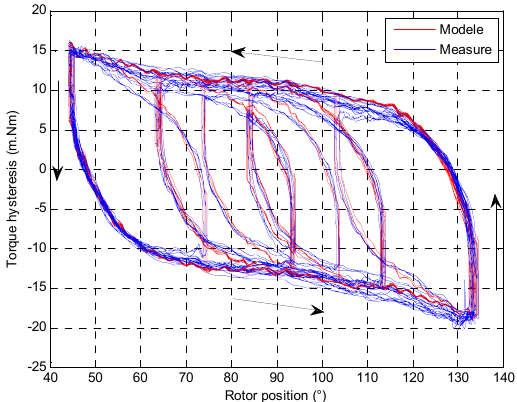
Figure 14. Hysteresis torque according to rotor position.